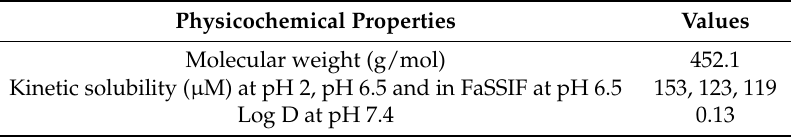
Abbreviation: FaSSIF Fasted State Simulated Intestinal Fluid.